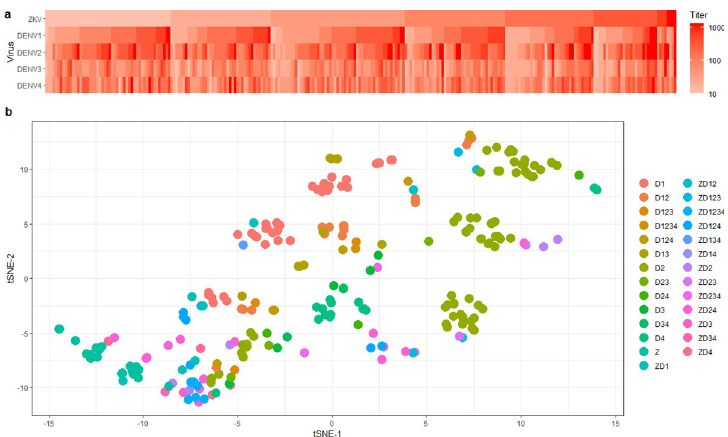
Fig 4. The relationship of nAb titer for ZKV and DENV. All nAb titer for ZKV and each DENV serotype were shown in a heatmap (a) using ggplot2 package. The nAb titer against ZKV or each DENV serotype were visualized in a t-distributed stochastic neighbor embedding (t-SNE) plot (b) using Rtsne package.